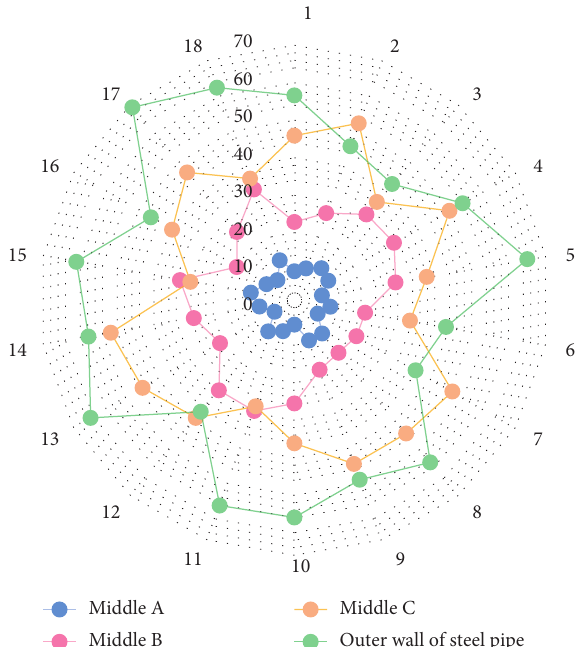
Figure 4: The axial and radial strain changes of D-shaped rein- forced concrete at different temperatures.